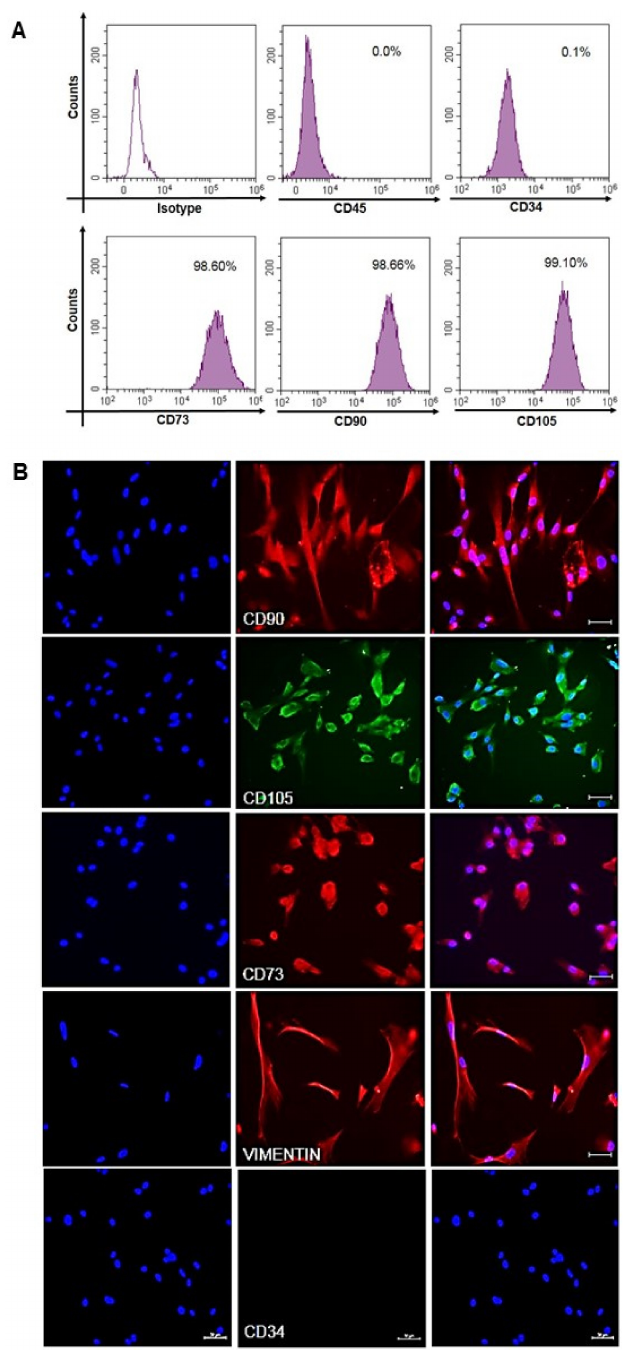
Figure 2. Expression of mesenchymal markers by the human umbilical cord-derived mesenchymal stem cells (UC-MSCs). ( A ) The cultured UC-MSCs showed negative expression of CD45 and CD34 but positive expression of CD73, CD90, and CD105, in flow cytometry. ( B ) Immunofluorescence was used to study the expression and cellular localization of CD90, CD105, CD73, VIMENTIN, and CD34. The left panel shows DAPI staining, the middle panel shows antigen specific staining and the right panel shows merged image of both DAPI and antigen specific staining. Bar size: 50 µ